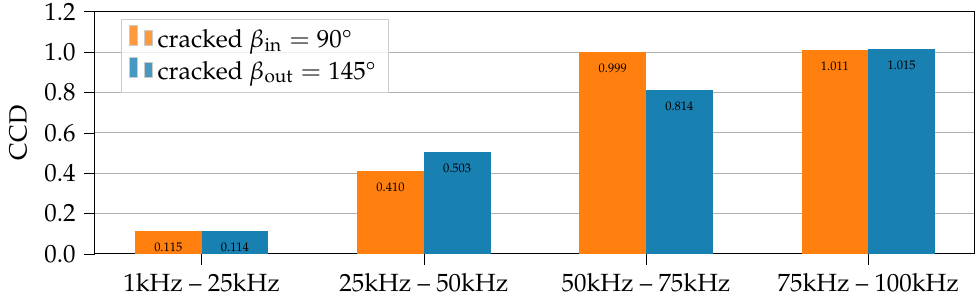
Figure 6. Detection of 2mm long cracks at different crack locations with damage metric CCD. Damage metrics are calculated with spectrum element S = G from FEM results.